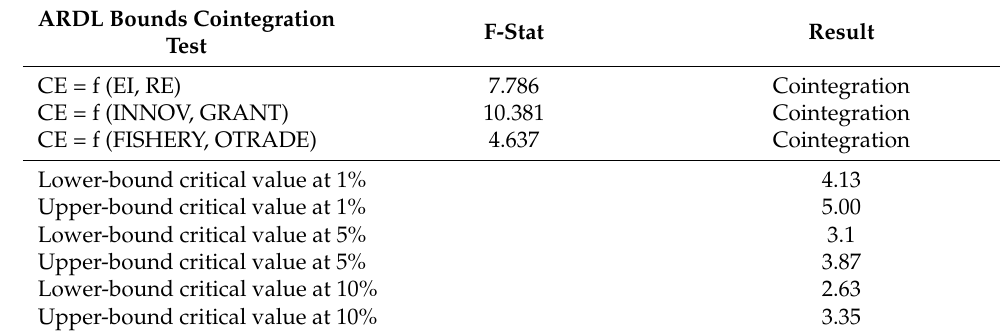
Table 5. ARDL bounds cointegration test.